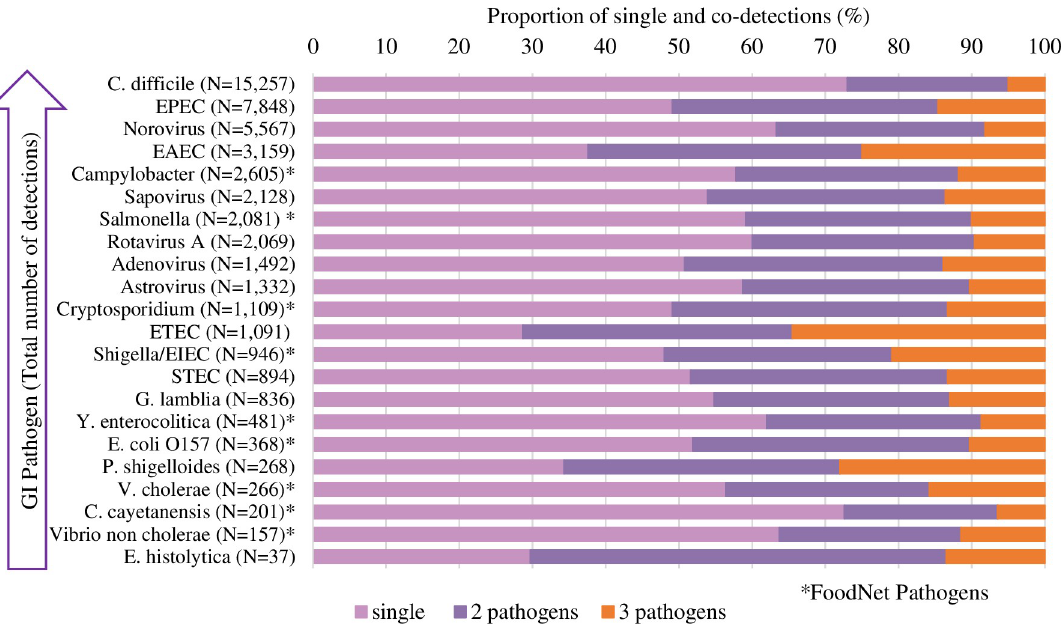
Fig 2. Total number of pathogen detections and overall proportion of single and co-detections for 22 GI pathogens in BioFire Trend from January 2016 through October 2018 (N = 50,192).